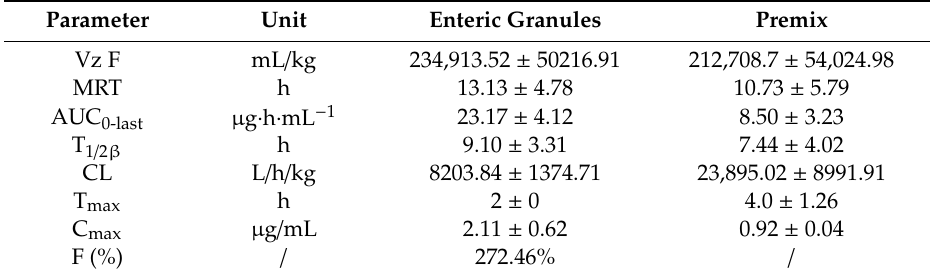
Table 4. Pharmacokinetic parameters of tilmicosin after oral administration of tilmicosin granules and premix (Mean ± SD, n = 6). Parameter Unit Enteric Granules